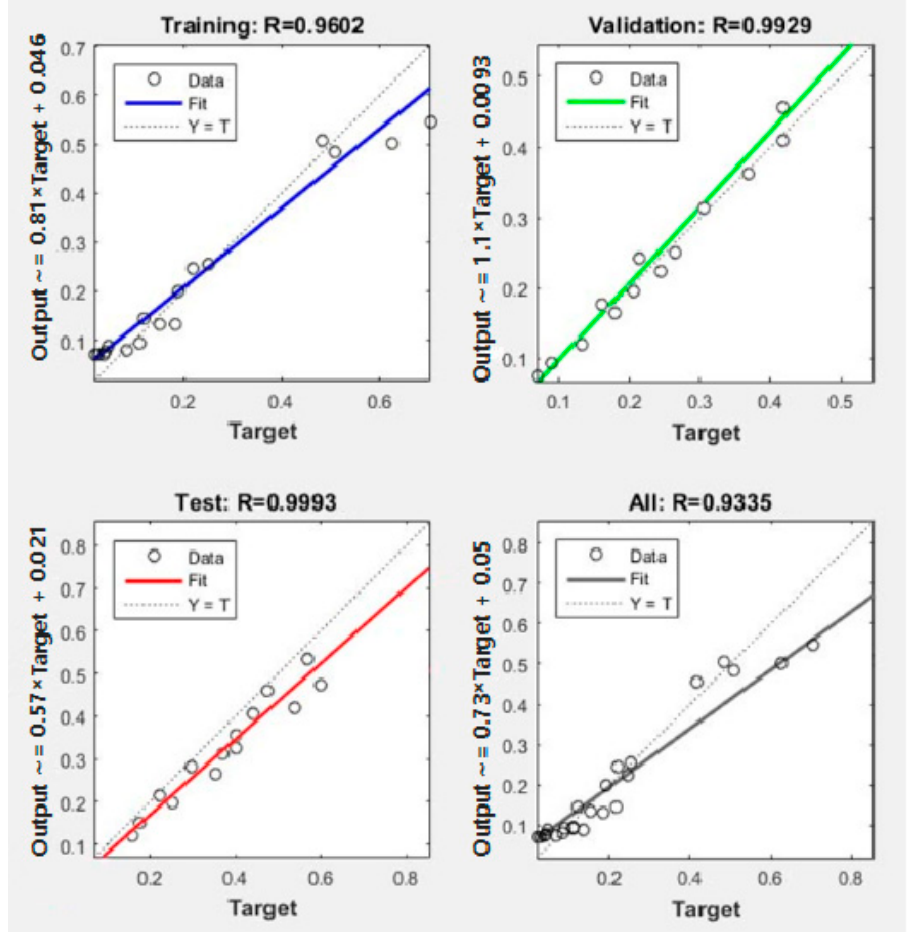
Figure 12. Correlations R between outputs and targets.